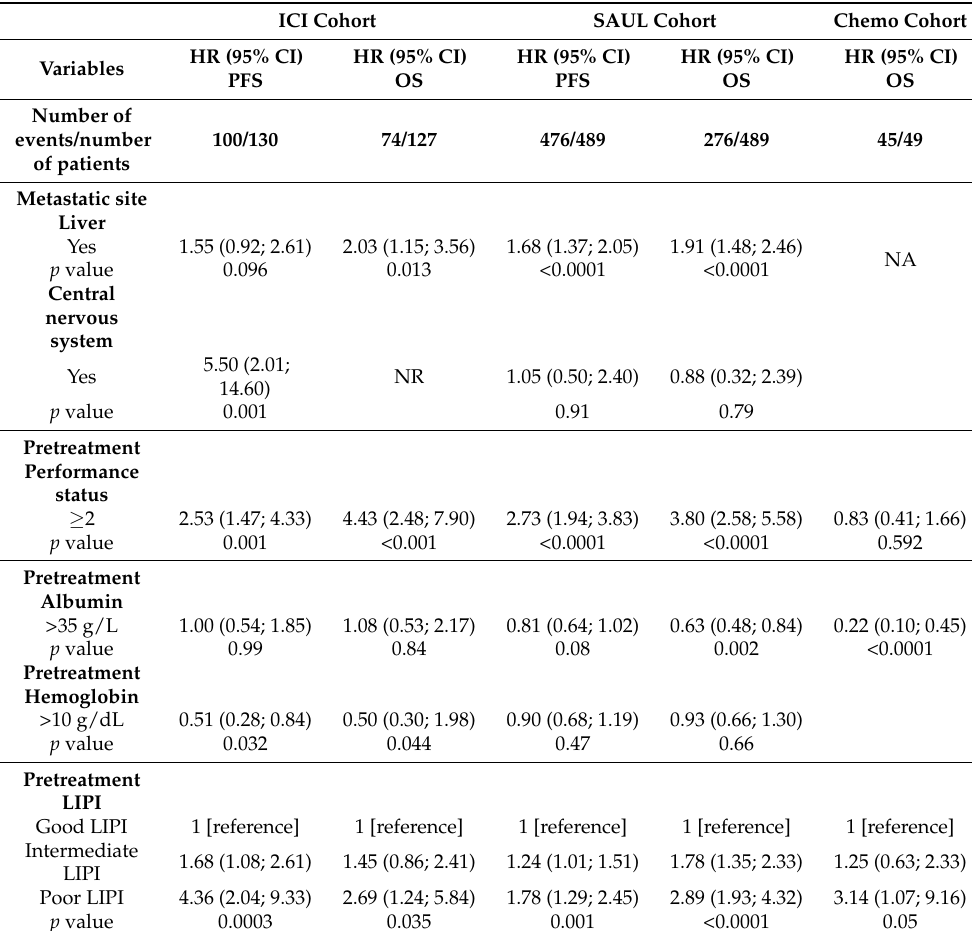
Table 2. Multivariate analysis for OS and PFS in the ICI and SAUL cohorts; Multivariate analysis for OS in the Chemo cohort. Chemo: chemotherapy; CI: confidence interval; dl: deciliter; g: gram; HR: hazard ratio; ICI: Immune checkpoint inhibitor; LIPI: lung immune prognostic index; n: number; NA: not available; OS: overall survival; PFS: progression-free